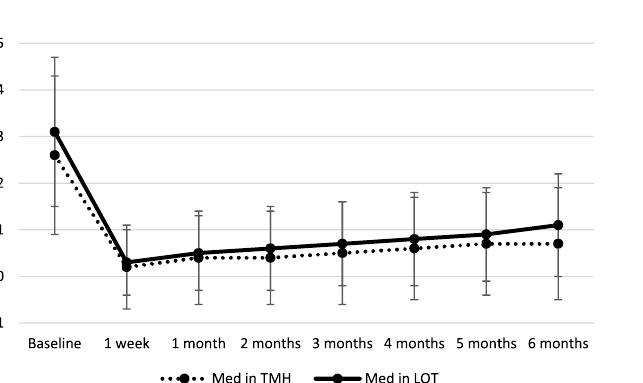
Figure 3. Transition of number of medications. Med: number of medications. Calculated using linear mixed model between TMH and LOT.